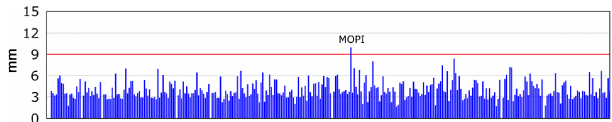
Figure 8. VENE (Venice Italy) time series of daily repeatability (for definition; see Fig. 7) in the up component for the period 21 July 1996–28 July 2007 (GPS weeks